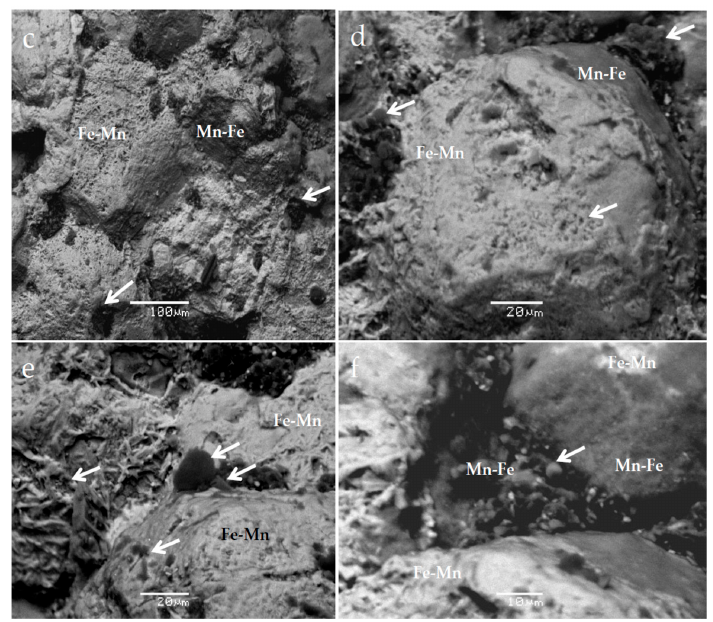
Figure 3. ( a ) Photograph of a Fe-Mn sample hosted in limestone, from the Legrena valley, Lavreotiki. The Fe-Mn phases appear as irregular, hard dark brown-black crust on the surface of carbonates. They are, in general, parallel to the shear plane of a thrust fault, suggesting a brecciated zone; Representative back scattered images from unpolished samples showing ( b ): Rounded fragments to spherical of Fe-Mn porous ore, cemented by dark brown-black Mn-Fe mineralization; ( c – f ): The Mn-Fe matrix hosting spherical isolated and aggregates of vestiges (white arrows) of varying size. A replacement of Fe-Mn hydroxides by Mn-Fe ones can be seen (Figure 2e,f).